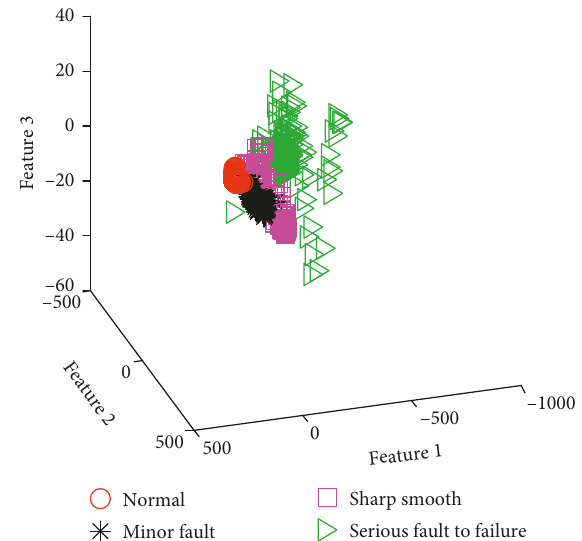
Figure 19: Dimension reduction results of subnetwork average degree.